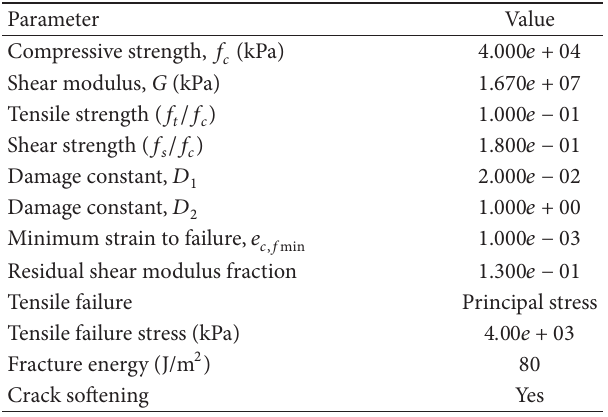
Table 5: Parameters of normal concrete in the RHT model. Parameter Value Compressive strength, 𝑓 𝑐 (kPa)